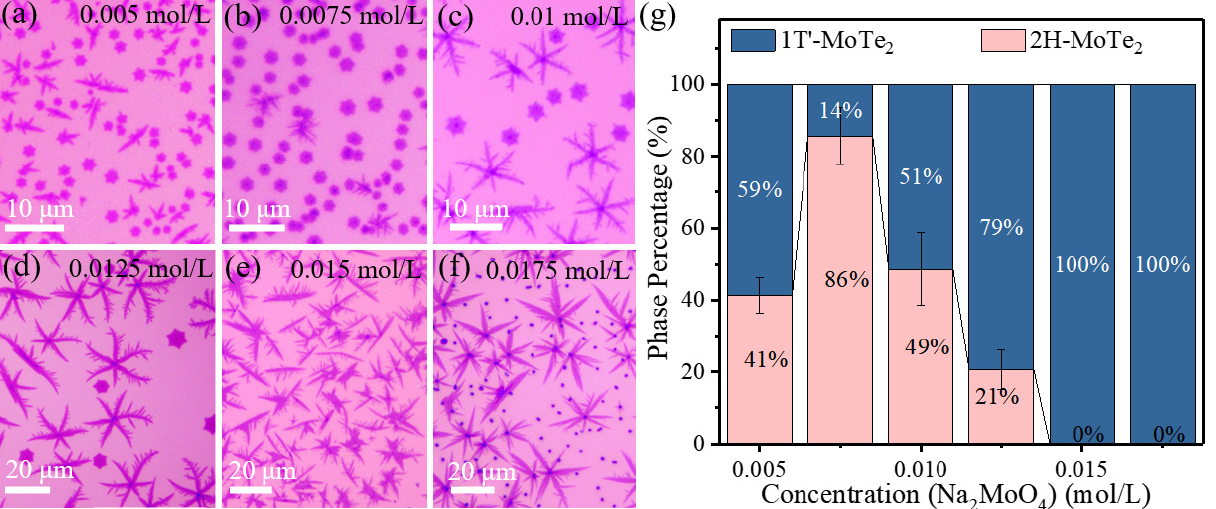
Figure 4. ( a – f ) Optical images of as-synthesized MoTe 2 under different concentrations of the Na 2 MoO 4 solution (0.005, 0.0075, 0.01, 0.0125, 0.015, 0.0175 mol/L) spin-coated on the bottom SiO 2 /Si substrate. ( g ) Dependence of 2H-MoTe 2 and 1T’-MoTe 2 percentage in the quantity as a function of the concentration of Na 2 MoO 4 solution.